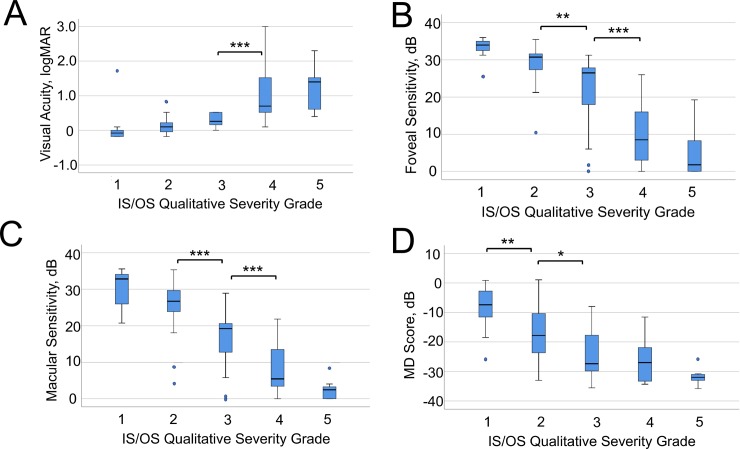
Box plots showing the distributions of values of variables concerning the central visual function in each grade of the qualitative IS/OS severity grade.A, BCVA, B, foveal sensitivity (FS), C, macular sensitivity (MS) and D, mean deviation (MD) of the 10–2 program of the HFA. The median value of each group is shown by the transverse line, and the box indicates the quartile range. Statistical significance; *, P < 0.05; **. P < 0.01; ***, P < 0.001.